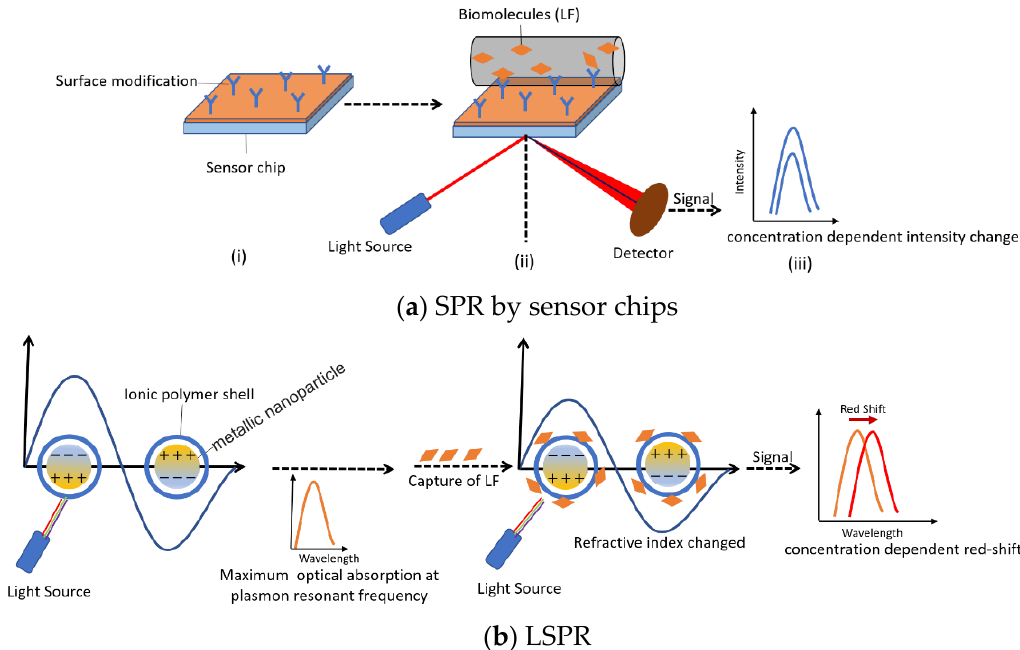
Figure 7. Lactoferrin detection by surface plasmon resonance (SPR) sensor. ( a ) SPR on sensor chips (i. Surface modification on sensor chips or gold nanoparticles; ii. The capture of lactoferrin on the surface was tested by laser beam; iii. Concentration dependent intensity change or red shift was recorded); ( b ) localized surface plasmon resonance (LSPR, the slight change of the refractive index of gold nano-shell after capture of lactoferrin results in the red shift of resonant frequency).